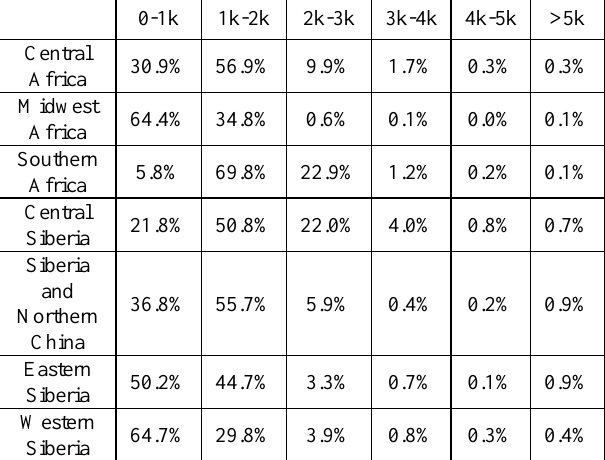
Figure 1. Climatological mean (a) and Climatological normalized standard deviation (b) of the daily average MISR plume height measurements, from January 2008 through July 2011. With respect to the case of Central Canada, we find that both similar amount of aerosol (58.3% in the boundary layer and 39% region, there is also a significant amount of aerosol (2.7%) found in the middle and upper free troposphere above 5km. The results in this region are consistent with primary forests